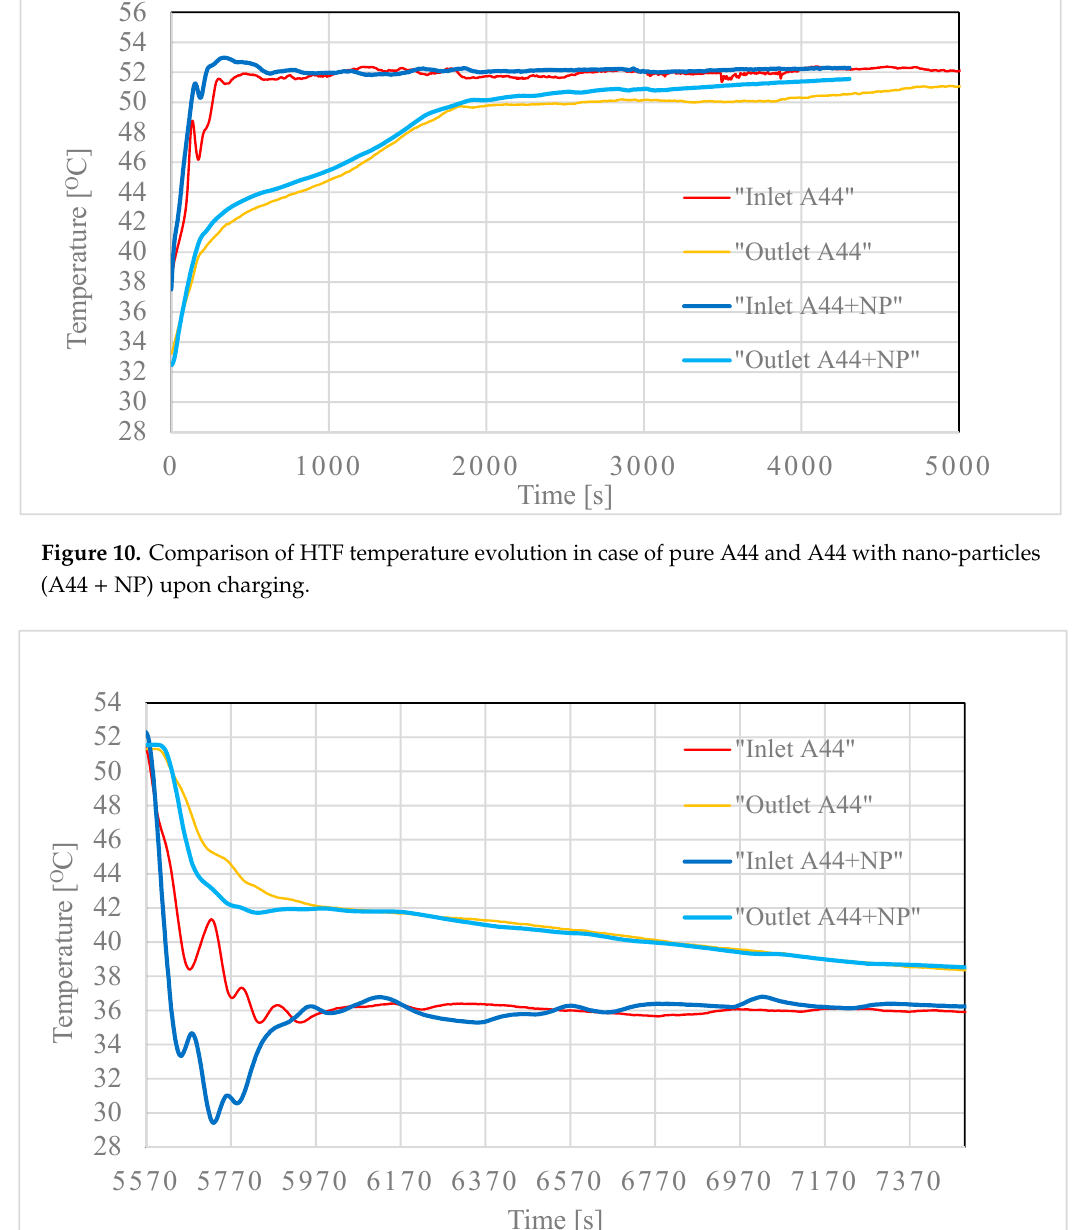
Figure 12. Mean temperature evolution of pure A44 and A44 + NP upon charging.